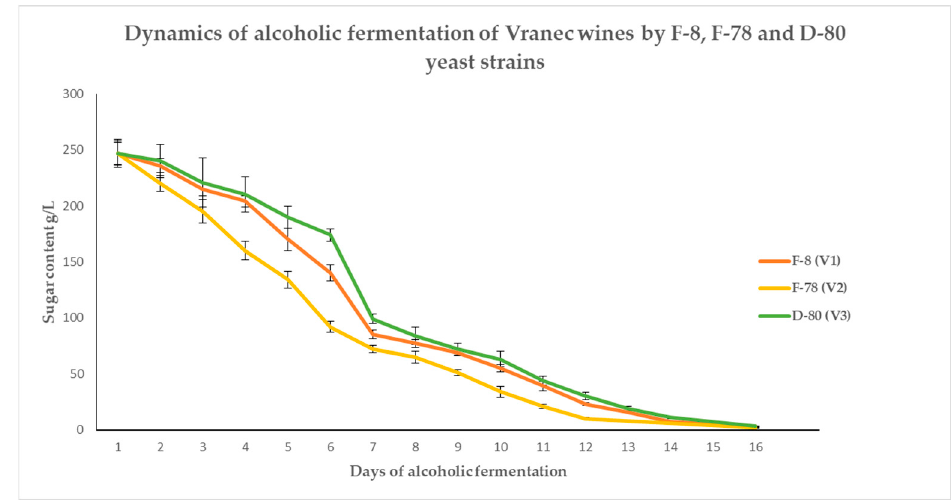
Figure 1. Dynamics of alcoholic fermentation of Vranec wines produced by autochthonous and commercial yeast strains, obtained by screening of the total amount of reducing sugars. The results refer to the mean values and standard deviations (mean ± STDV), expressed as g/L. Mean ± STDV were calculated from one replicate of each fermentation type (see Table 1) and four analytical measurements. Wine type abbreviations are defined in Table 1.